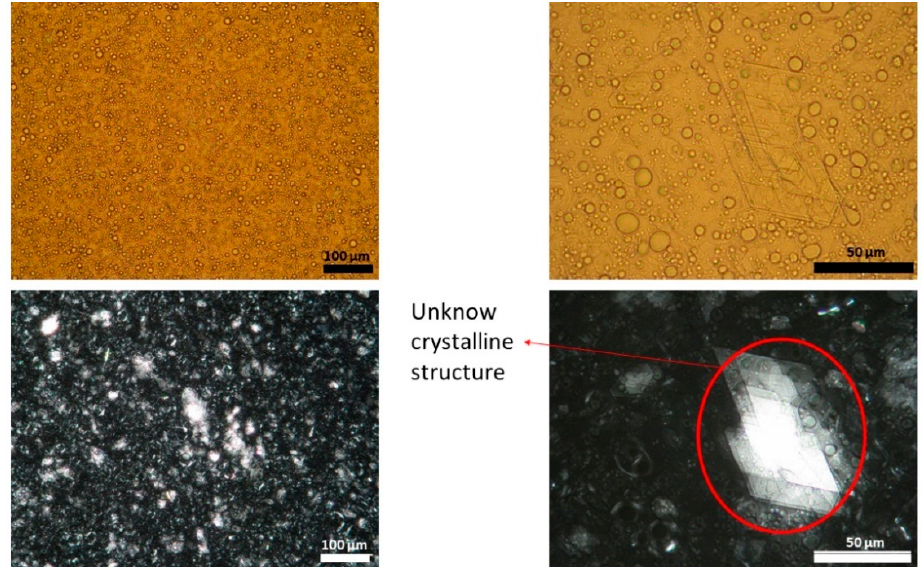
Figure 2. Light (upper panel) and polarized (lower panel) microscope images of batch two capsaicin emulsion at different magnifications. Unknown crystalline structure is highlighted. A high variability in droplet size could be observed.